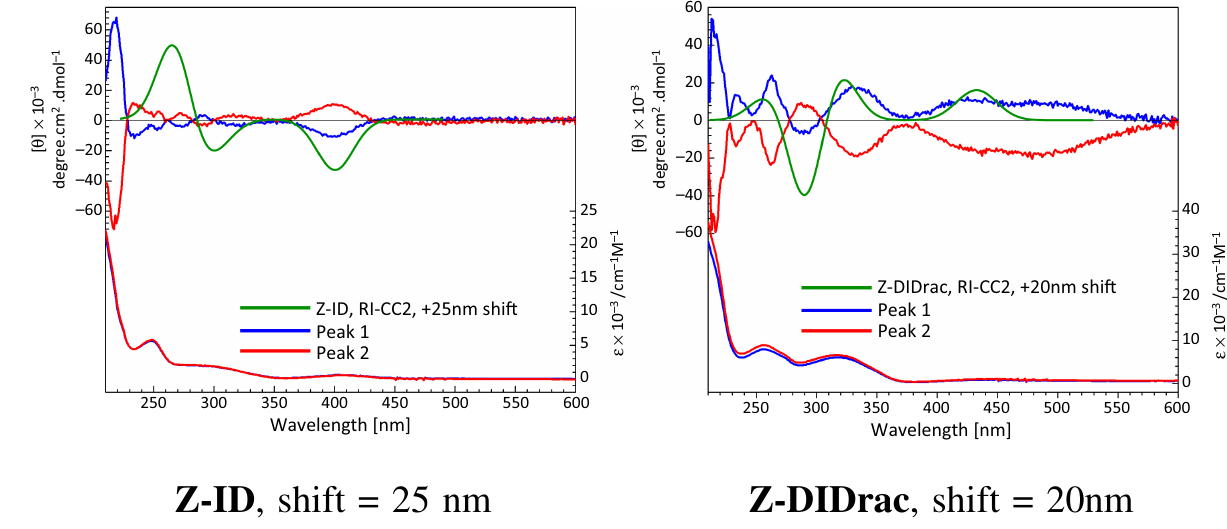
Figure 5. Upper panels: simulated RI-CC2 CD spectra (shifted) of Z-ID and Z-DIDrac in comparison to the experimental results [25]. The two experimental curves come from the two enantiomers that were separated using chiral column chromatography. Lower panels: the corresponding experimental absorption